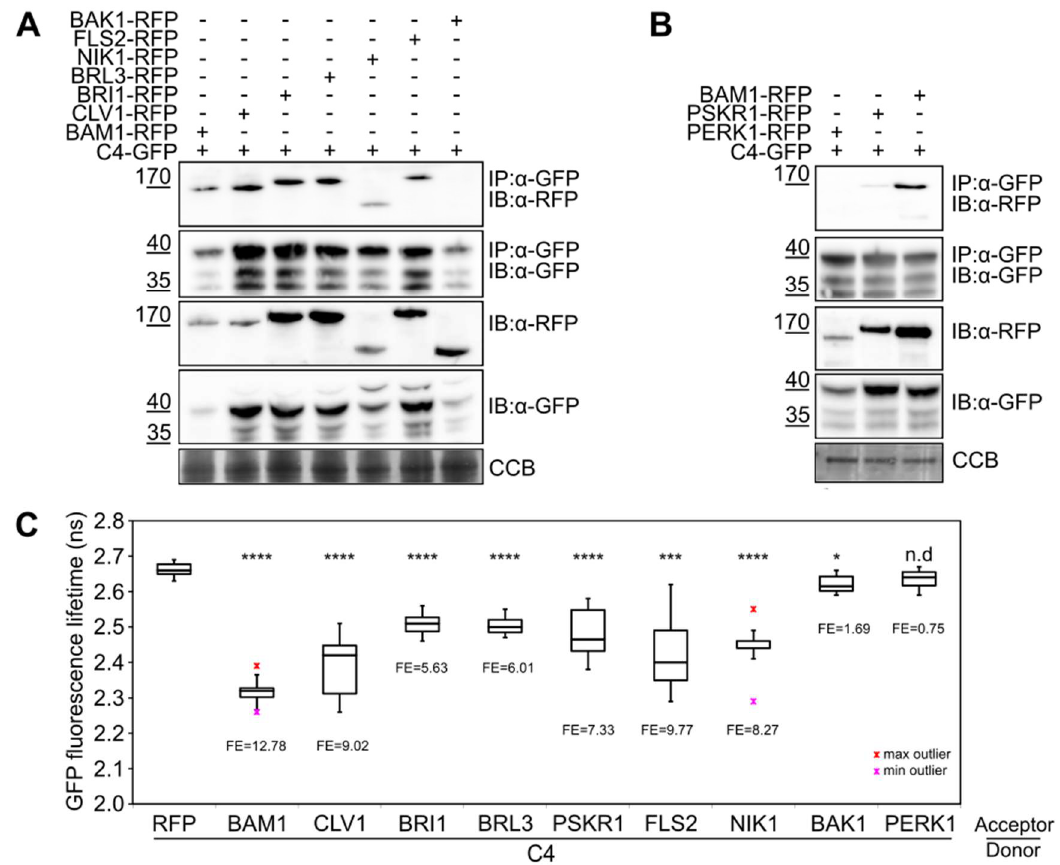
Figure 2. C4 interacts with several leucine-rich repeat (LRR)-RLKs in vivo. ( A ) Co-immunoprecipitation of BAM1-, CLV1-, BRI1-, BRL3-, NIK1-, FLS2-, and BAK1-RFP with C4-GFP following transient expression in N. benthamiana. IP: immunopurification, IB: